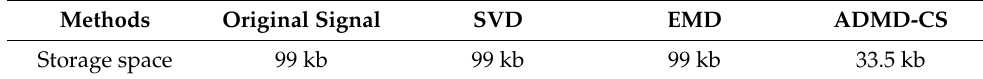
Table 5. Storage space for simulation signal with different